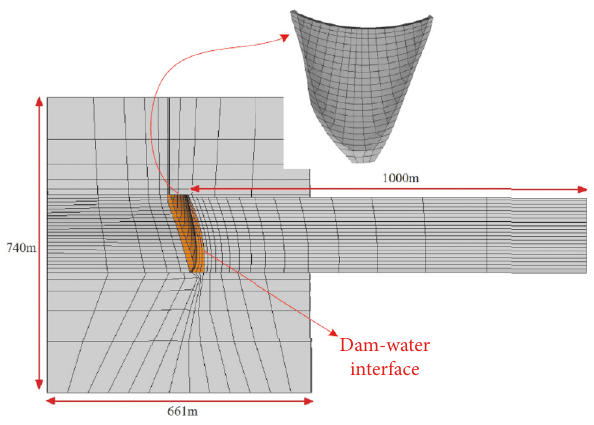
Figure 4: Finite element model of dam, reservoir, and foundation